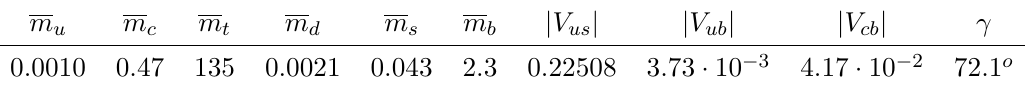
Table 3 . Inputs to the numerical scan, with masses given in GeV. The MS masses from ref. [57] are evolved up to (cid:22) = 2 TeV using 3 loop QCD RGE. The CKM entries and the angle (cid:13) are taken from measurements of tree-level processes as averaged by the